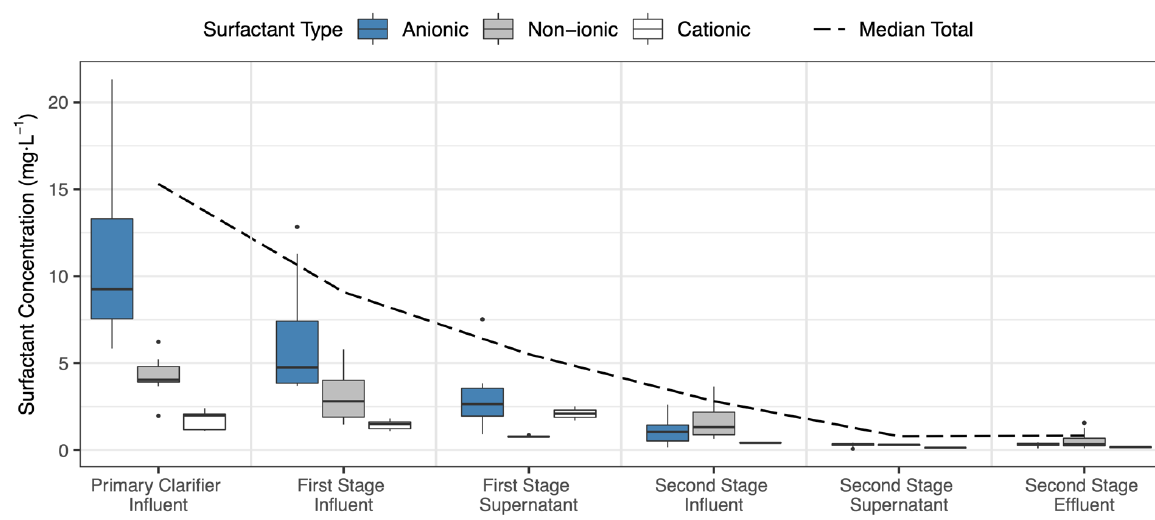
Figure 6. Surfactant concentrations of successive treatment stages divided into surfactant types.